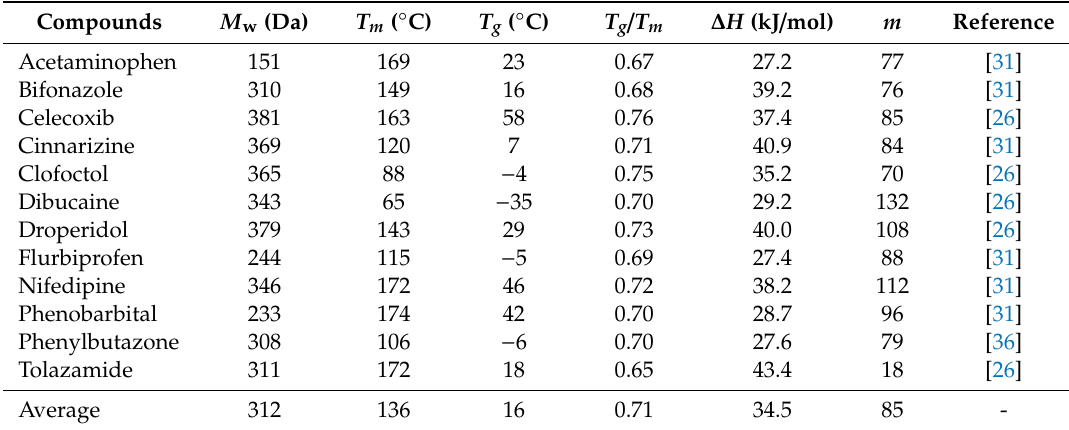
Table 3. Examples of Class 2